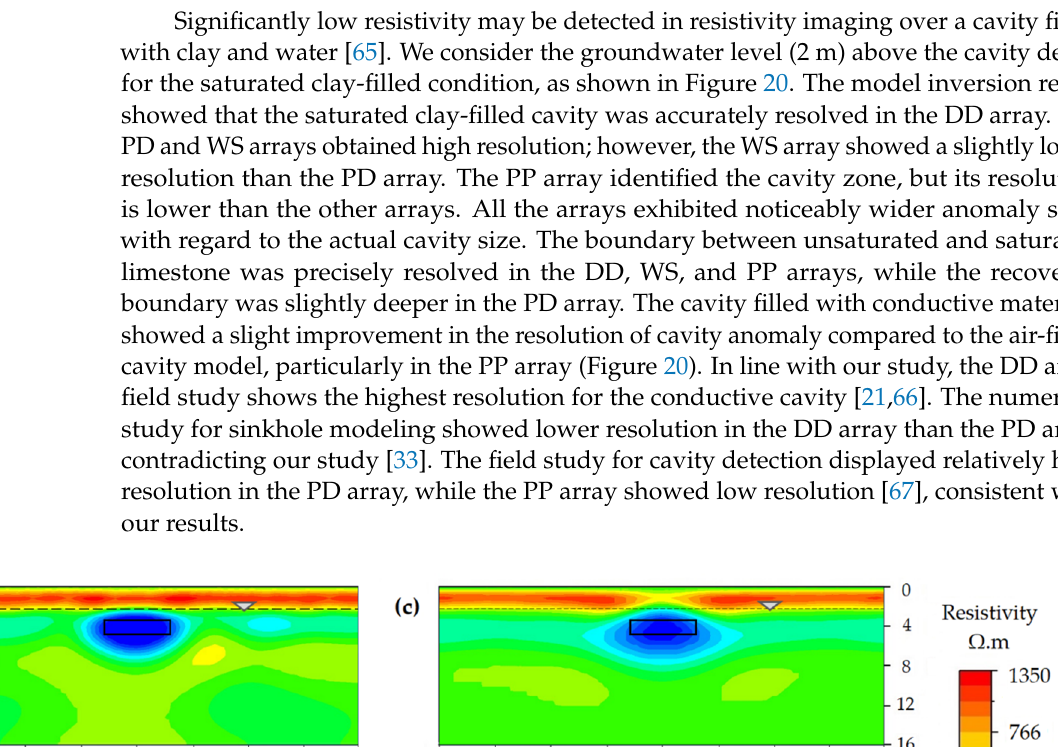
Figure 19. The inverted resistivity model for a cavity filled with dry clay using: ( a ) DD array, ( b ) PD array, ( c ) WS array, ( d ) PP array. The rectangular box indicates the actual cavity target.